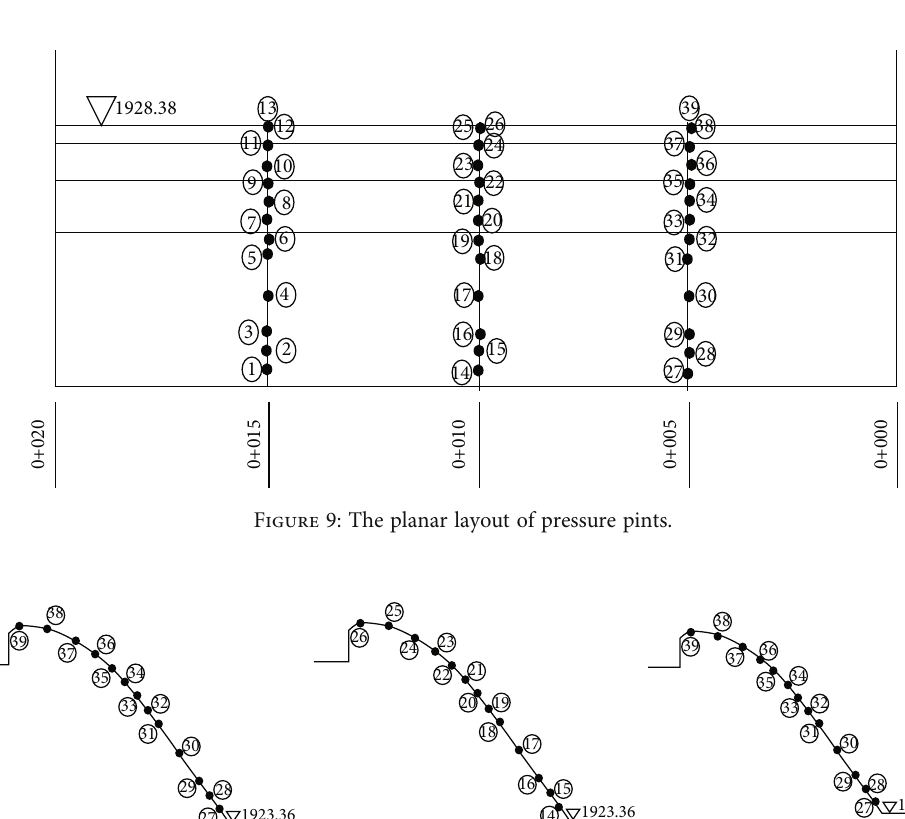
Figure 8: The comparison between numerical and experimental values of water depth at the side wall under the collated fl ood level